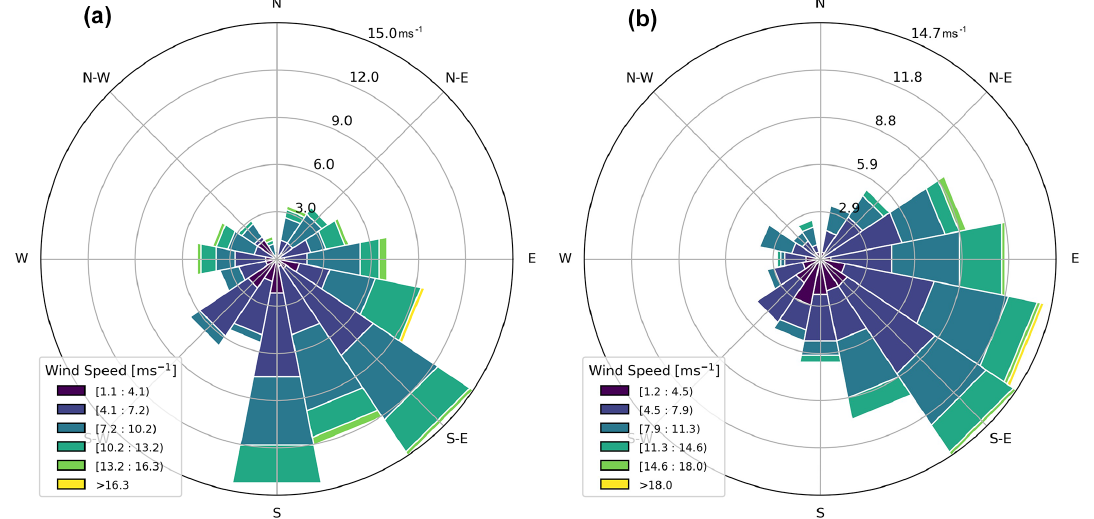
Figure 8. Wind roses showing the distribution of wind speed and direction during all winters (April–October) in the study period, when the active polynya (a) did not increase in area and (b) did increase in area. These winds are calculated for a region close to the Iceberg Chain that the polynya forms from, shown by Fig. S2.